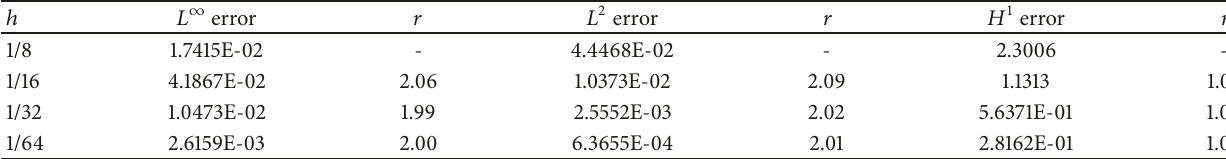
Figure 2: The 𝐿 ∞ , 𝐿 2 , and 𝐻 1 error for the control, state, and adjoint state under uniform refinement of the mesh. Table 3: Errors of the adjoint state for different error